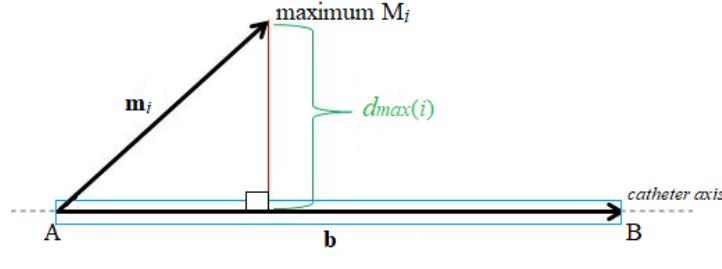
Figure 13. Principal scheme of the point-to-line method.